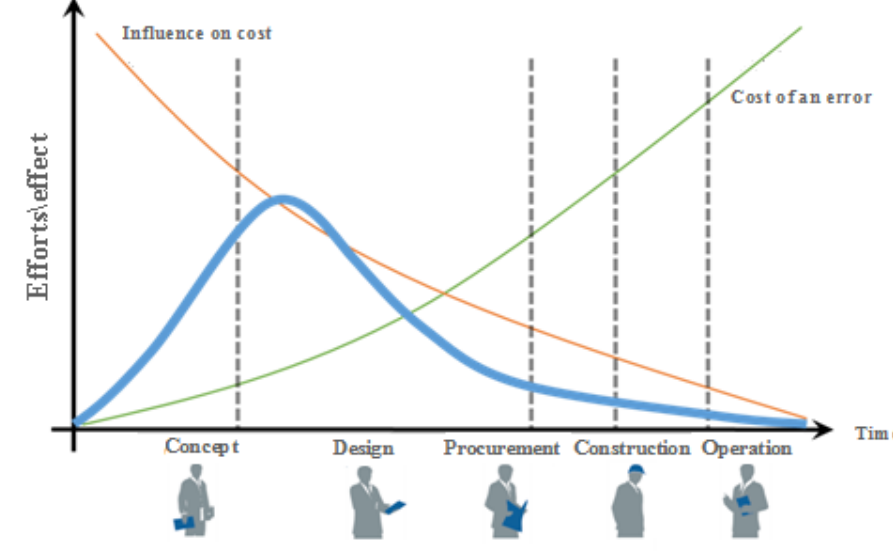
Fig. 4. Costs of design within BIM spread over a real estate asset